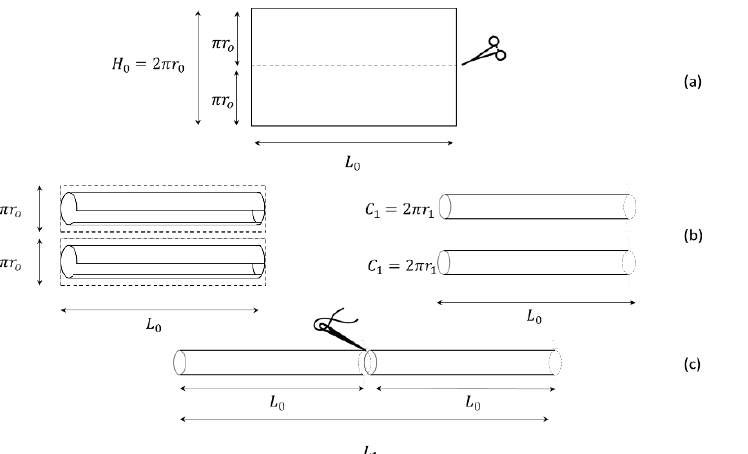
Figure 3. LILT procedure. ( a ) Longitudinal cut of the developed bowel in two equal rectangles. ( b ) Rolling of the two rectangles bowel around the long side. ( c ) Anatomical geometry of the new bowel cylinders.